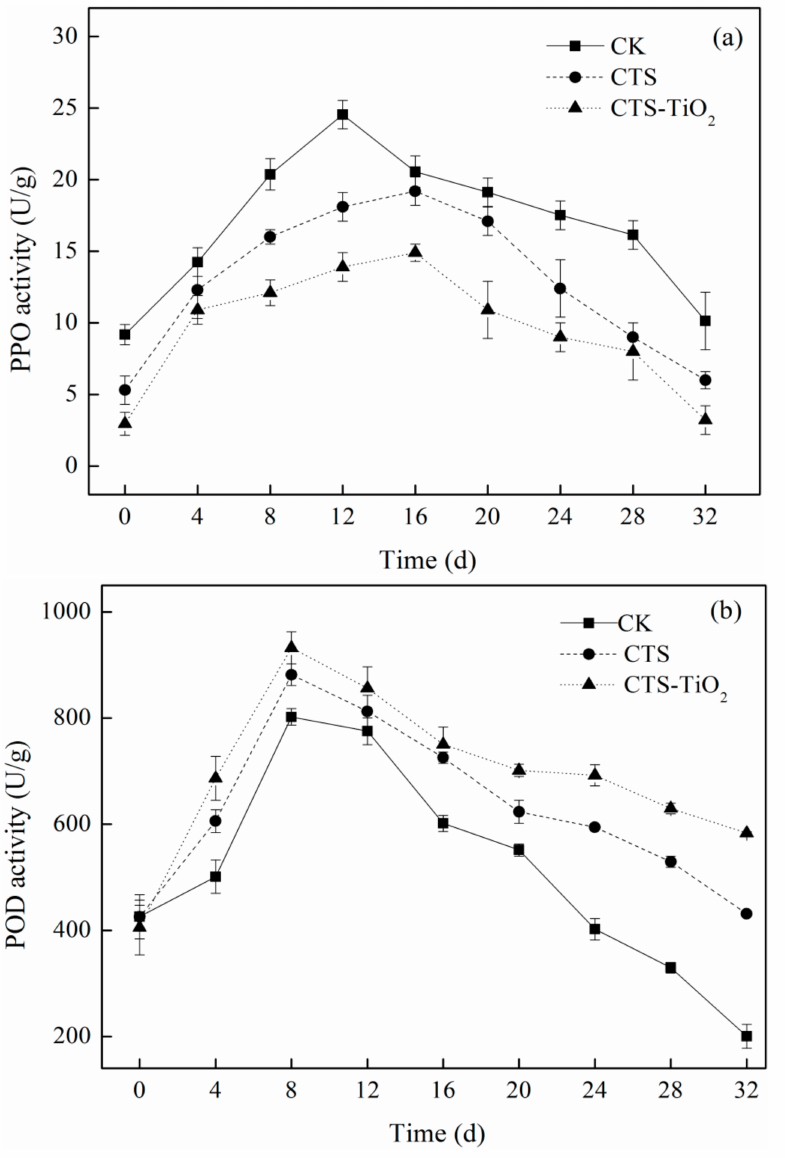
Figure 2. Effects of different treatments on the PPO ( a ) and PPO ( b ) of blueberry fruit during 32 days of storage at 0 ◦